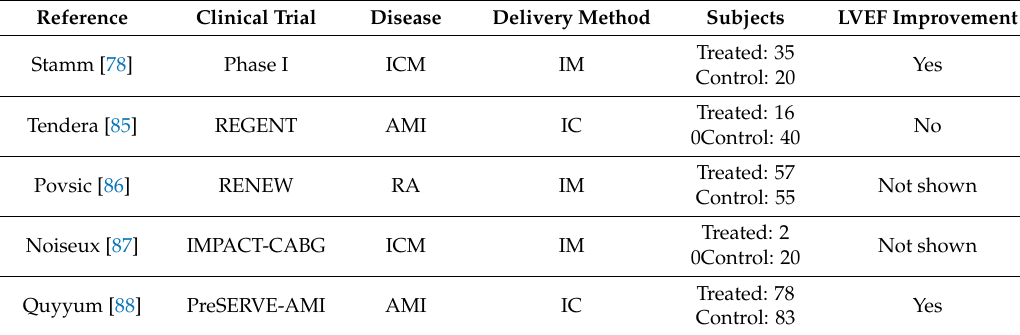
Table 4. Clinical trials with BM-HSCs for cardiac regeneration.